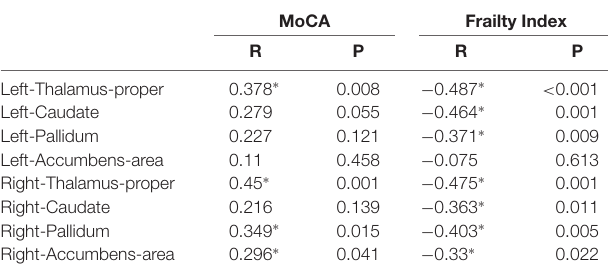
MoCA Frailty Index